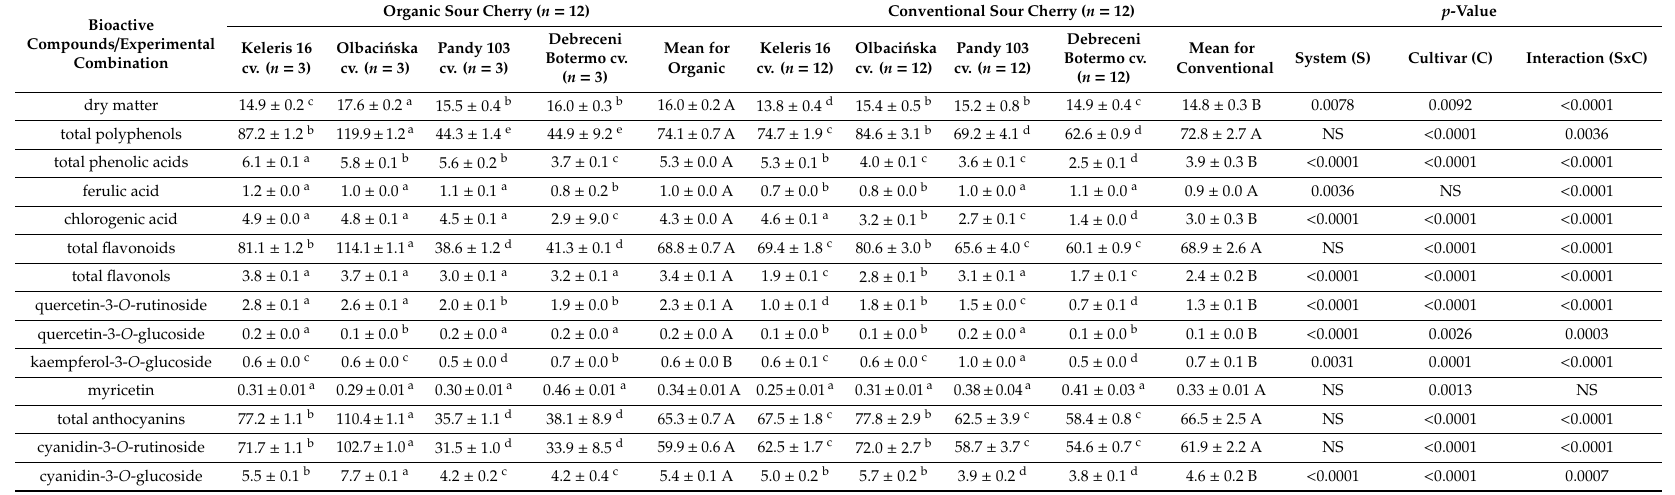
Table 1. The content of dry matter (in g / 100 g FW) and polyphenols (in mg / 100 g FW) in examined sour cherry cultivars in 2015.